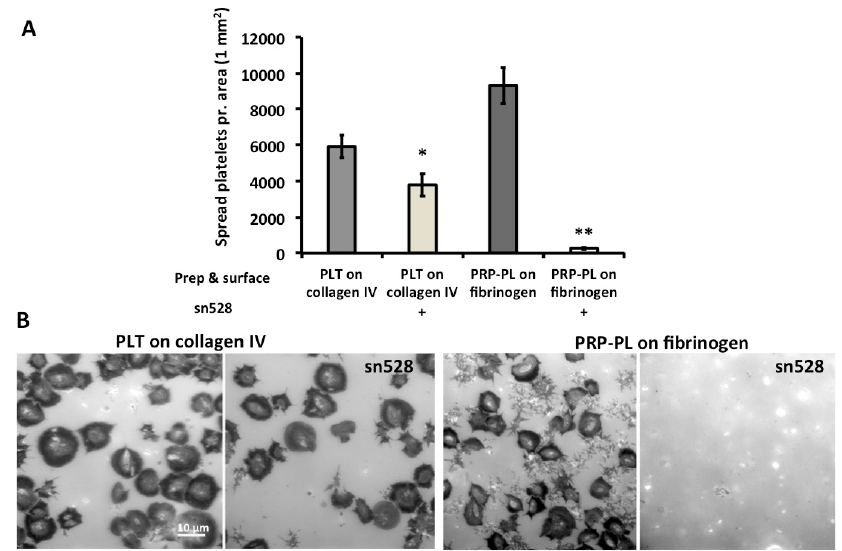
Figure 9. PLT and PRP-PL treated with or without the α IIb β 3 inhibitor sn528, on collagen IV and fibrinogen surfaces. ( A ) Inhibition of integrin α IIb β 3 by sn528. Effect of integrin α IIb β 3 inhibition shown by platelets on collagen IV and fibrinogen surfaces, with and without addition of the inhibitor sn528 (x-axis). Number of platelets per 1 mm 2 : y-axis. Wilcoxon rank-sum test was used, * p-value < 0.05 and ** p-value < 0.001. N experiments = 4. Error bars show Standard Error. ( B ) PLT on collagen IV with and without the addition of the sn528 ligand. PRP-PL on fibrinogen with and without addition of the sn528 ligand. Scale bar: 10